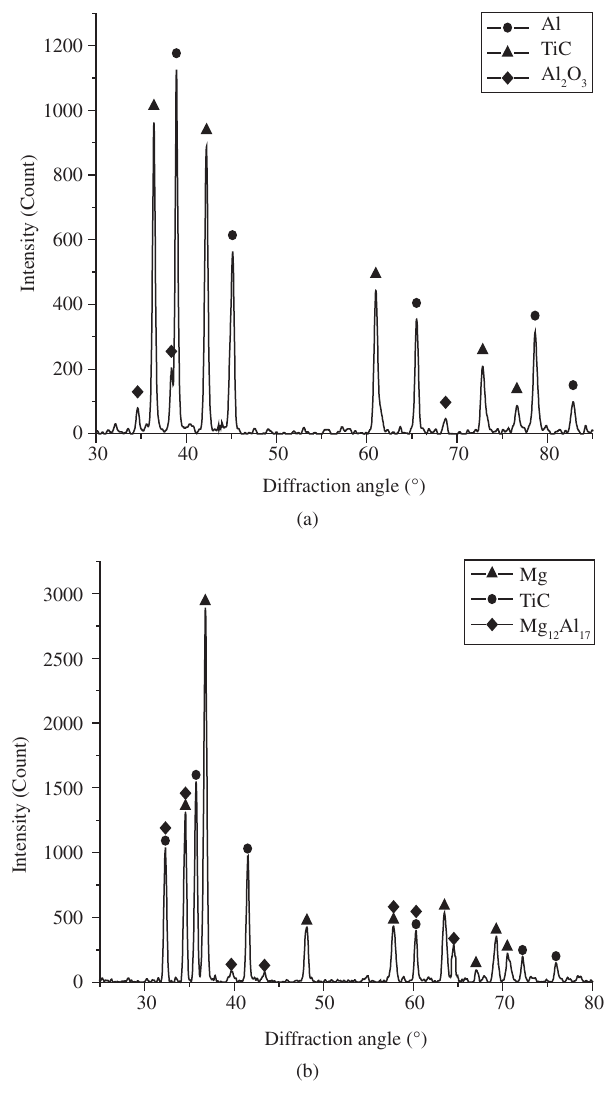
Figure 1. X ray diffraction patterns of samples a) prefabricated block; and b) magnesium matrix